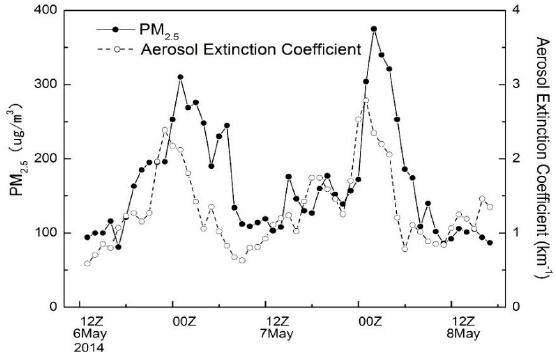
Figure 4. Hourly change in the aerosol extinction coefficient (AEC) data for Chengdu and the observed PM 2.5 (particulate matter less than 2.5 µm in diameter) concentration during the pollution event.